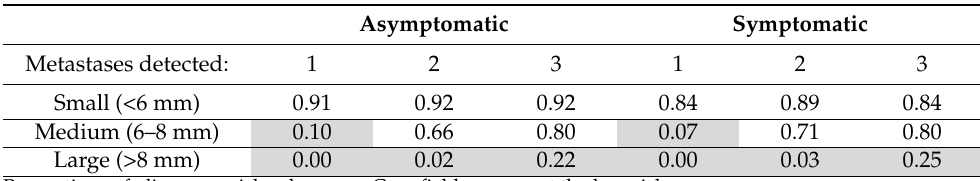
Table A9. Proportion of oligo+ within patients with detected oligo-metastases in the Random Detection Size Scan scenario.